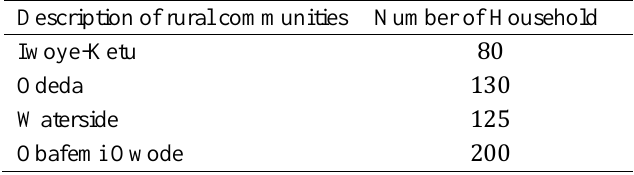
Data of the Study Area Description of rural communities Number of Household